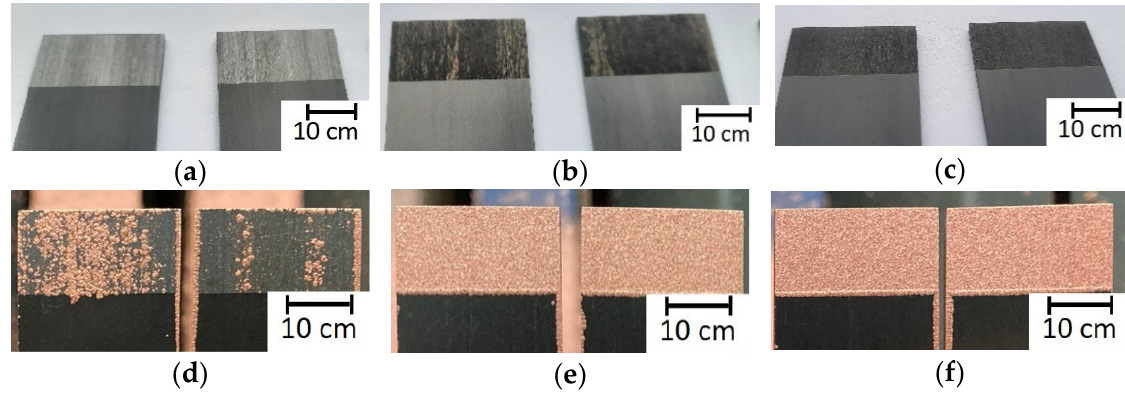
Figure 5. Optical photographs before ( a – c ) and after ( d – f ) the coating deposition treatment for CFRP surfaces with ( a , d ) insufficient, ( b , e ) optimal, and ( c , f ) damaging ablation conditions. Transferred to the approximation in Section 2.2.1, this means that a thick matrix layer on top of the fibers (corresponding to insufficient ablation ) is more critical for the coating adhesion than a comparatively thin matrix layer (corresponding to damaging ablation ).